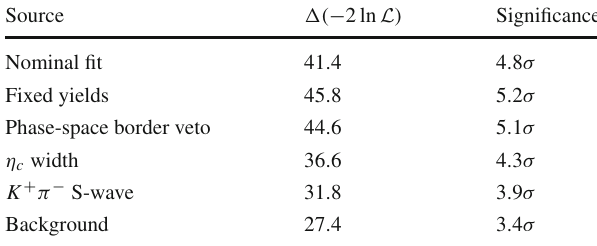
Table 5 Significance of the Z c ( 4100 ) − contribution for the system- atic effects producing the largest variations in the parameters of the Z c ( 4100 ) − candidate. The values obtained in the nominal amplitude fit are shown in the first row